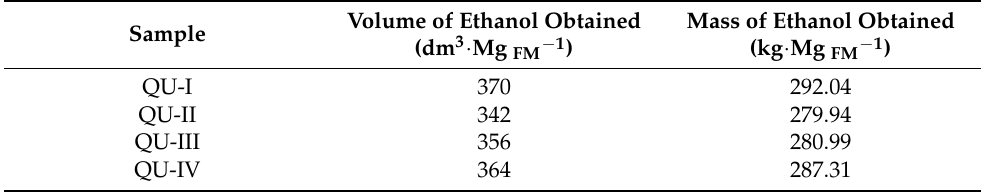
Table 3. Volume of pure ethanol obtained from the analysed maize in each quarter. Sample